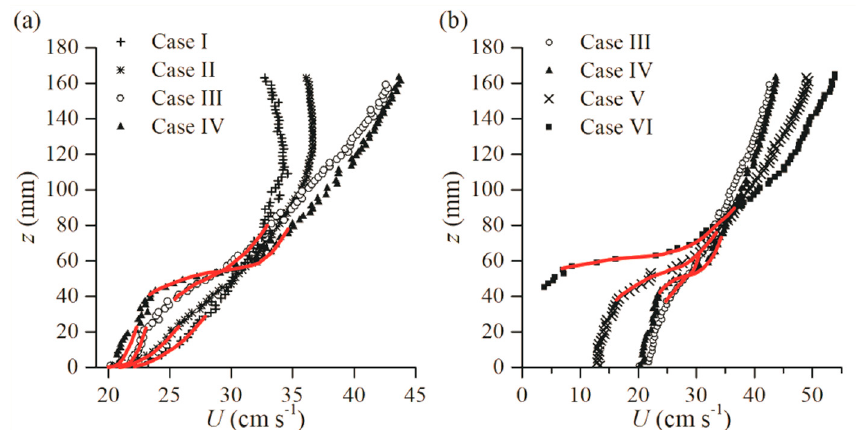
Figure 5. U profiles with different vegetation densities, ( a ) from Case I to Case IV and ( b ) from Case III to Case VI.